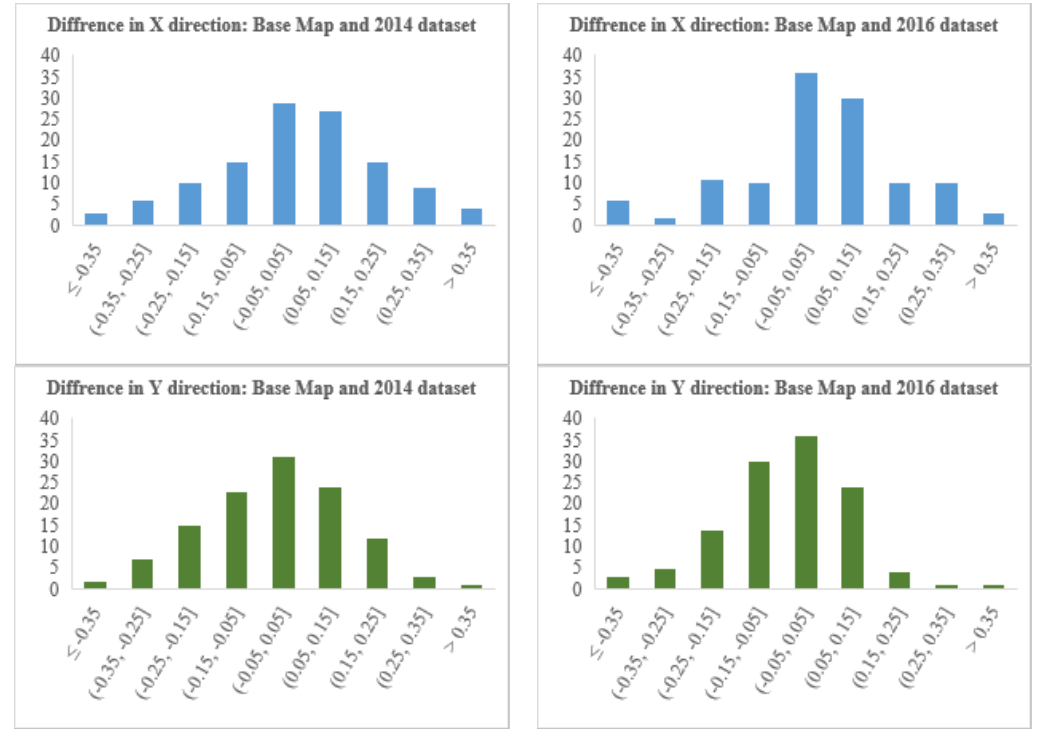
Figure 2. Histograms of residuals between planimetric coordinates measured on oblique images and derived from the base map for both